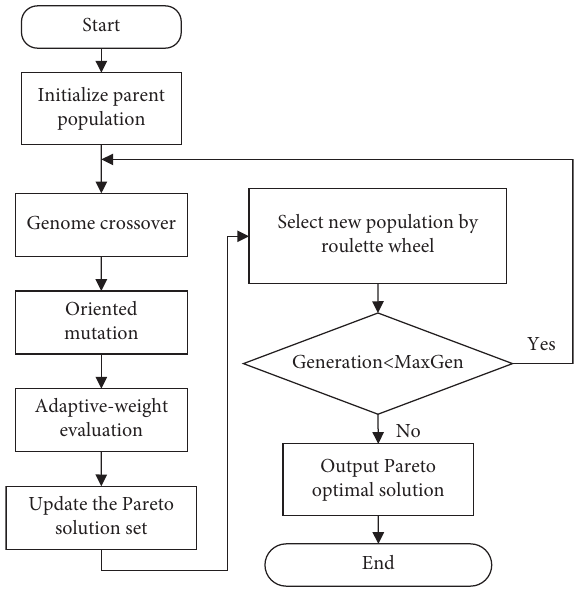
Figure 5: AWGA algorithm overall process. Table 1: Station list of Line